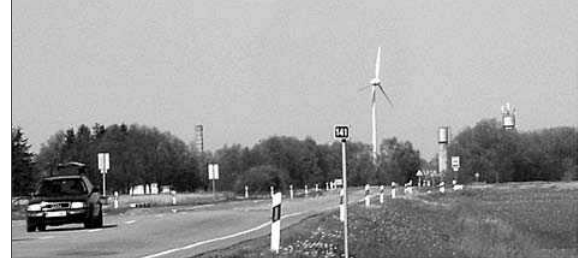
Fig. 2. First windpowerstation near